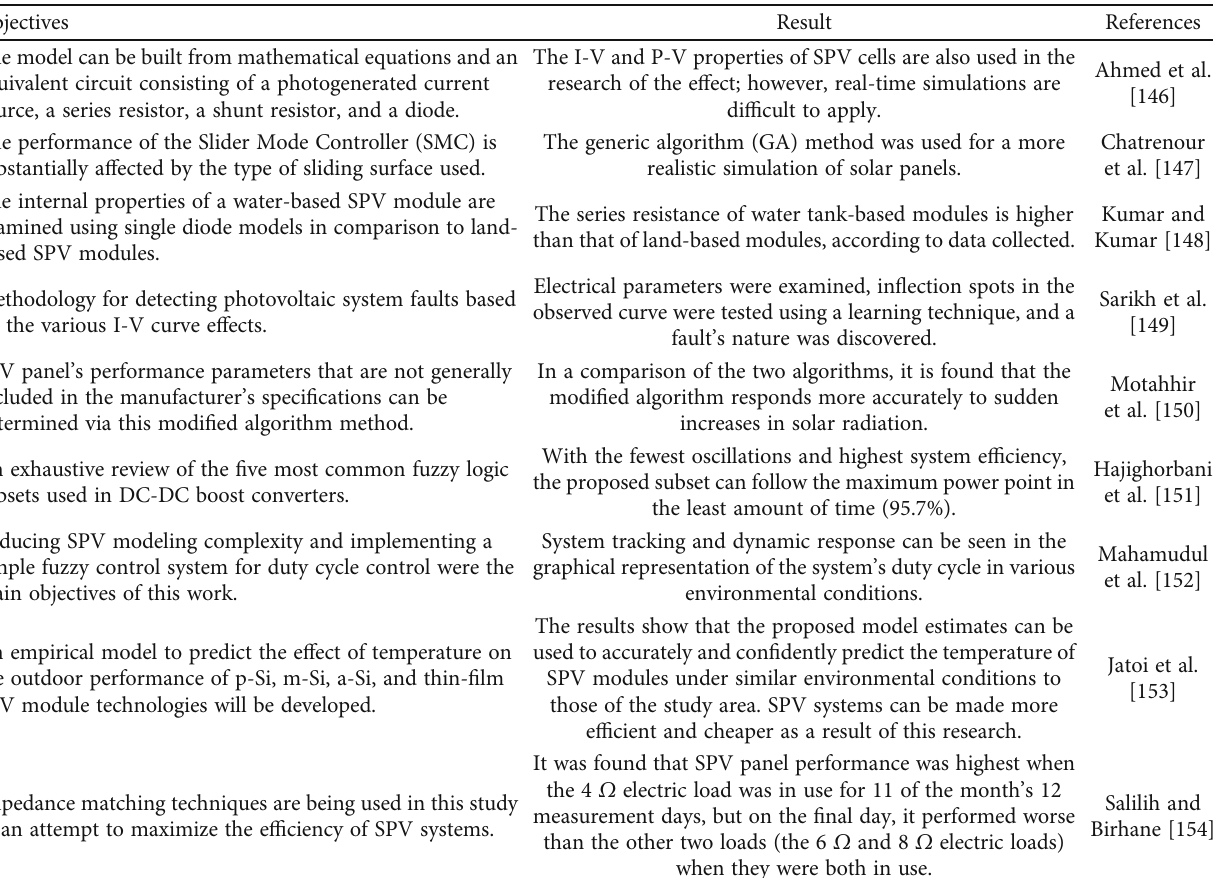
Table 5: Studies on the e ff ect of internal